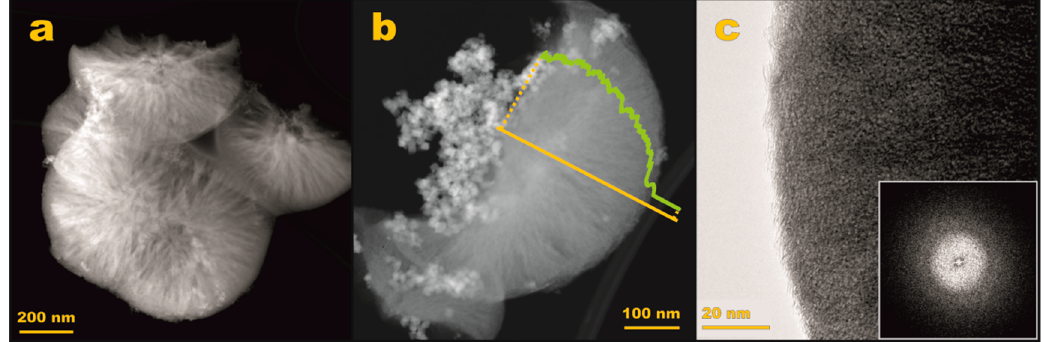
Figure 5. Electron microscopic analysis of the synthesized mesoporous carbon support. HAADF STEM imaging reveals porosity and overall morphology of the support ( a , b ), whereas HR TEM ( c ) and calculated FFT pattern ( c , inset) its amorphous nature.